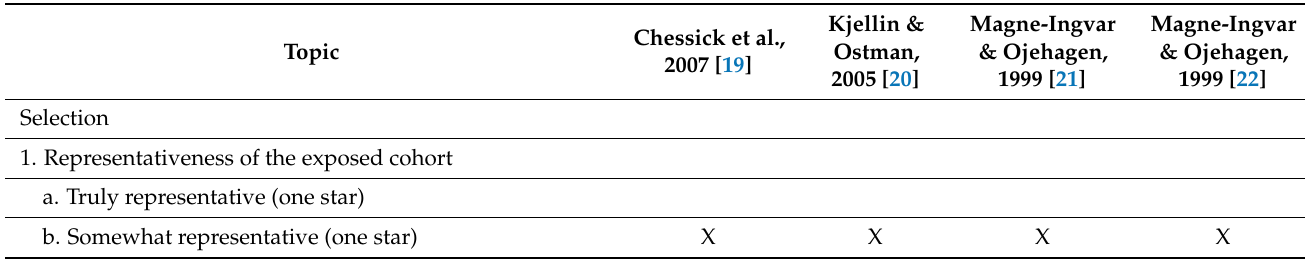
Table A1. Quality assessment 1 of quantitative